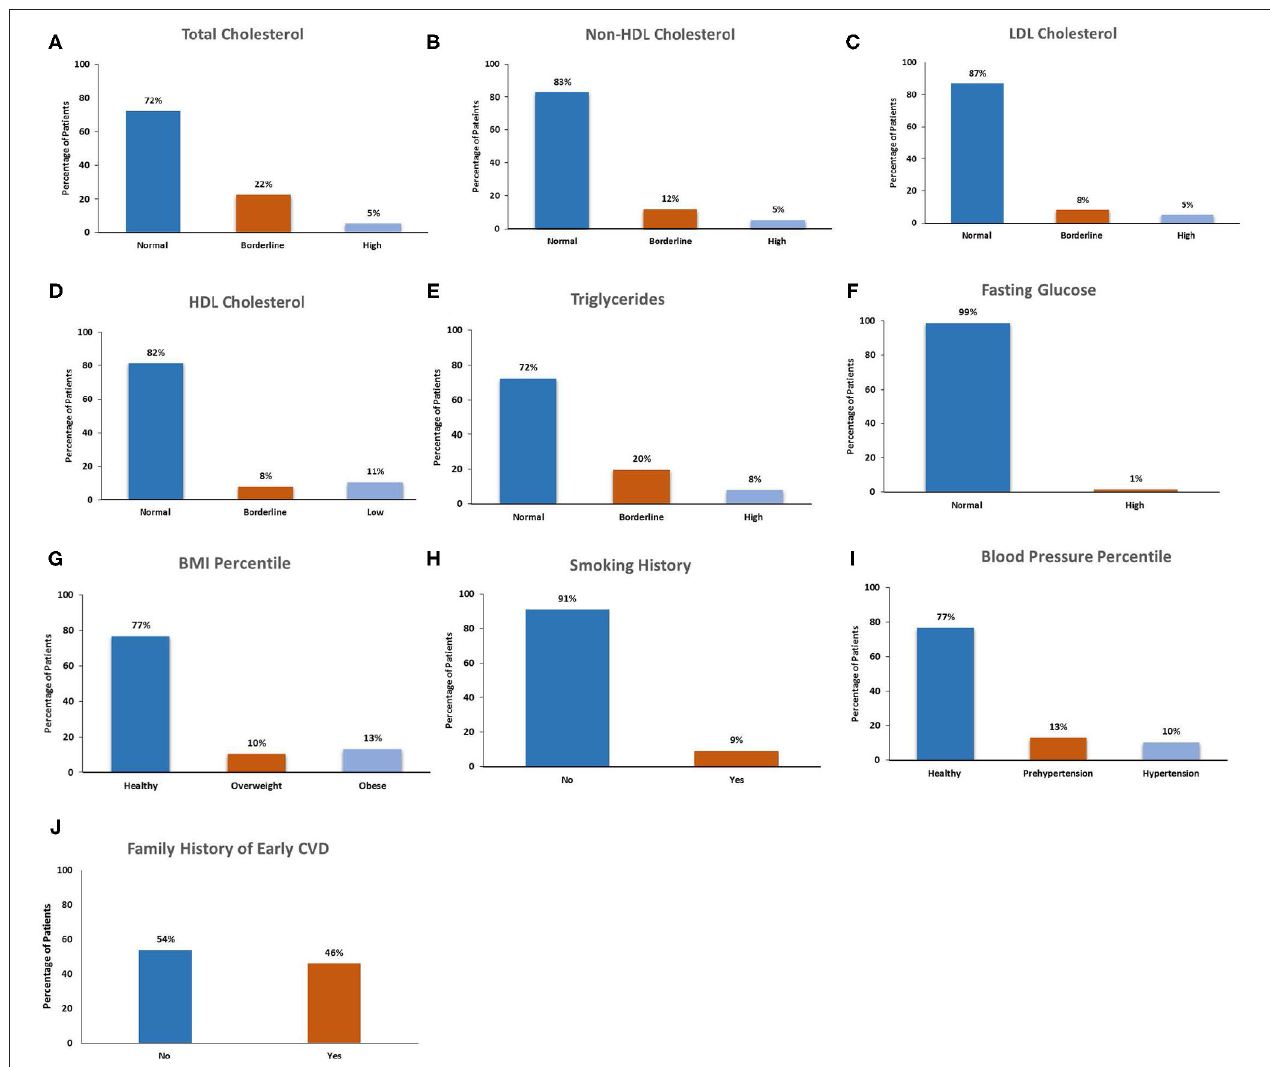
FIGURE 1 | CVD risk factor categorization among children and adolescents with MDD.